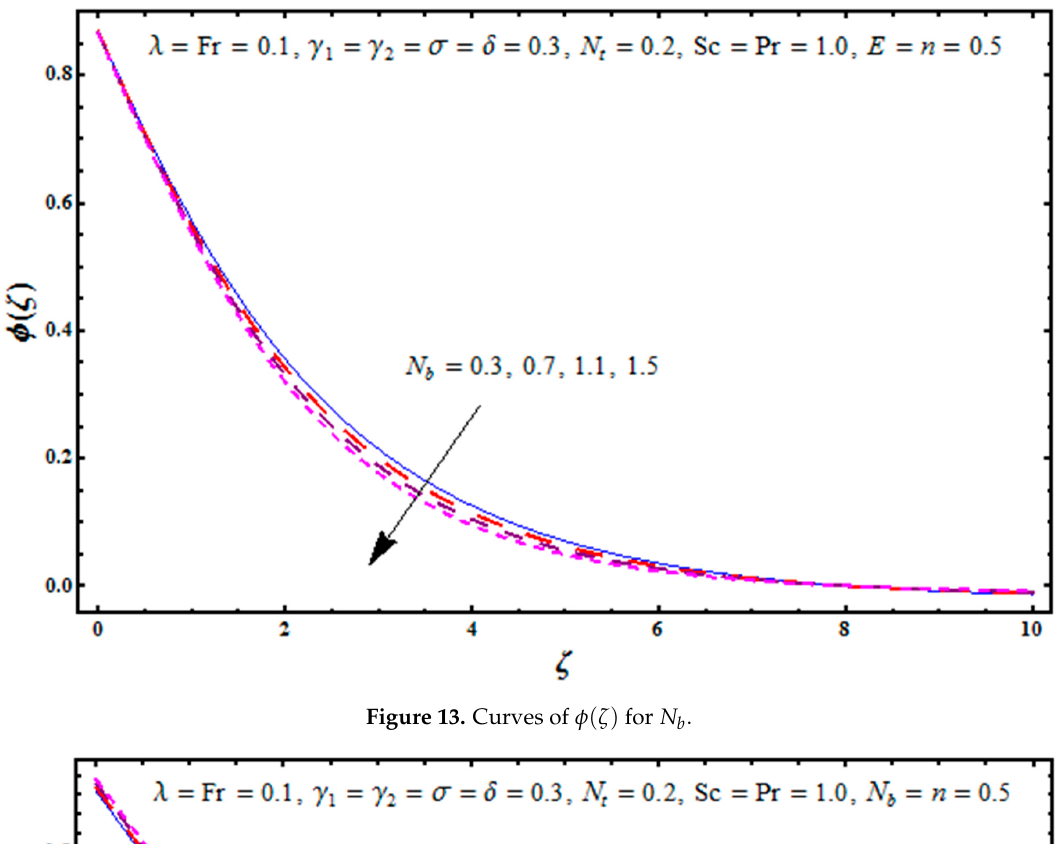
Figure 13. Curves of φ ( ζ ) for N b .